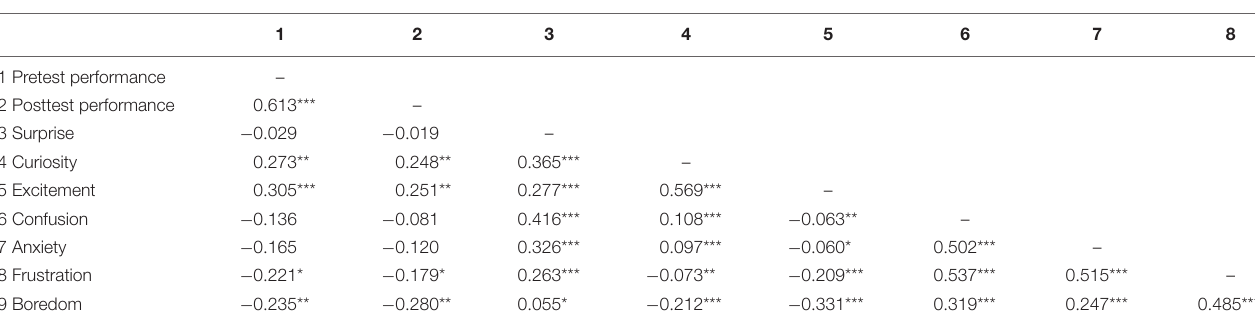
TABLE 2 | Bivariate pearson correlations of the observed